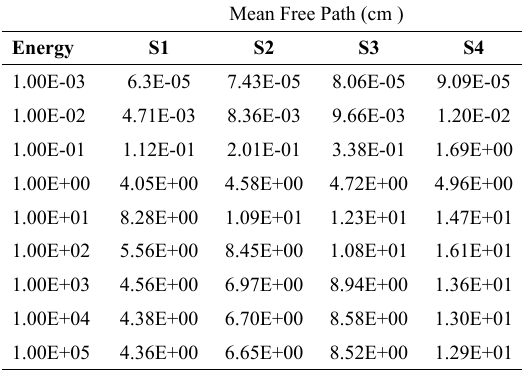
Table 2. Theoretical Result of Mean Free